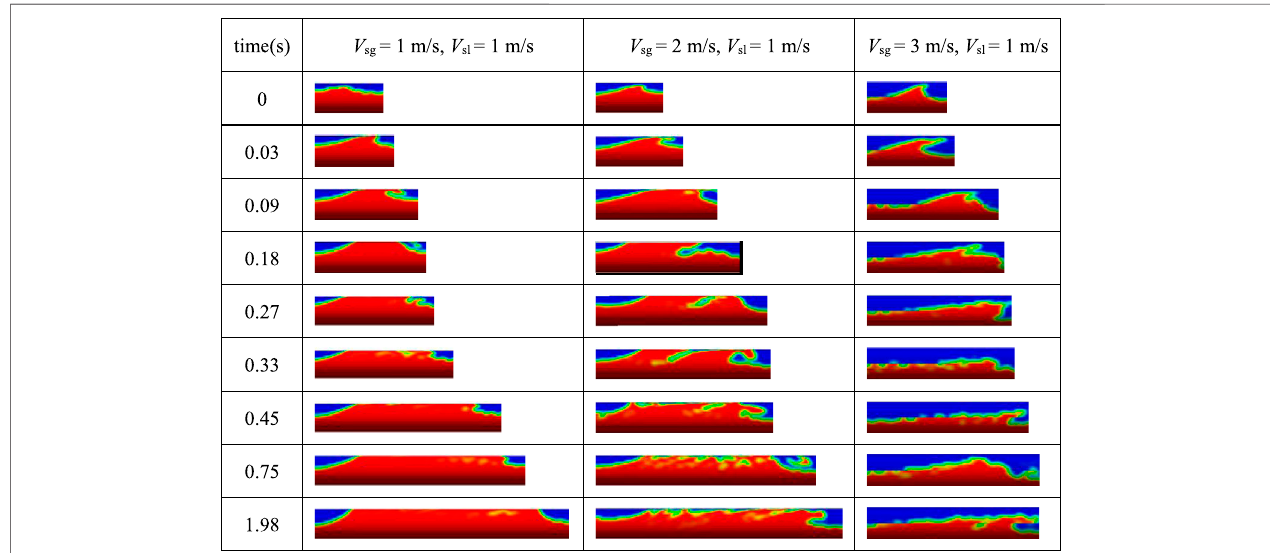
FIGURE 13 | Variation of a developing slug with time with increasing gas-liquid speed difference.